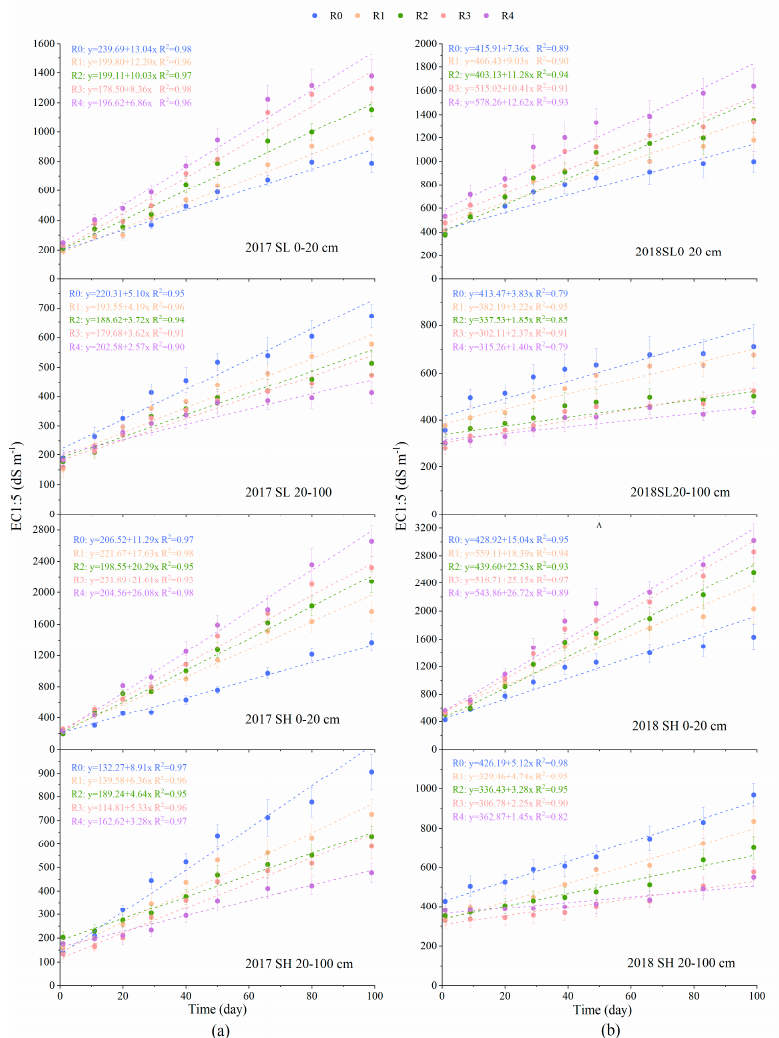
Figure 4. Soil salinity (EC1:5) variation within the straw incorporation layer (0–20 cm) and non-straw incorporation layer (20–100 cm) in 2017 ( a ) and 2018 ( b ). Note: R0, R1, R2, R3, and R4 indicate the straw incorporation rates of 0, 4.5, 9.0, 13.5, and 18.0 t ha − 1 , respectively; SL indicates the low salinity water (1.92 dS m − 1 ); SH indicates the high salinity water (3.20 dS m − 1 ).